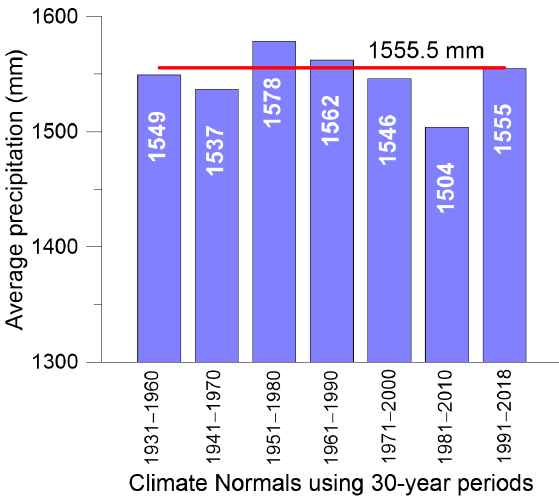
Figure 9. Mean annual precipitation in the period 1931–2018 and mean annual mean values for each of the possible periods of Climatological Normals from 1931–1960 to 1991–2018.